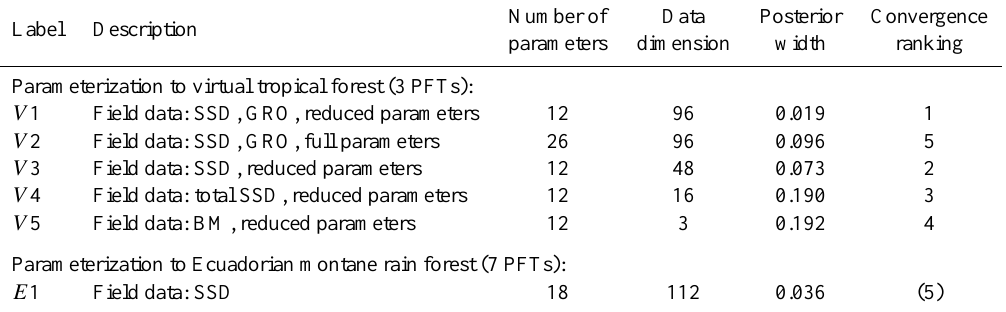
Table 2. Overview of parameter estimations with different models, parameters and summary statistics. Abbreviations for the data: SSD = stem size distribution (16 10cm classes); GRO = mean stem diameter growth for each of the 16 10cm stem diameter classes; BM = biomass. If not stated otherwise, the data type was available for each PFT separately. If we use the mean over all PFTs, we label this “total”. “Full parameters” means that all parameters listed in Tables 1 and 2 of the Supplement are estimated inversely. “Reduced parameters” means that only recruitment, mortality, maximum growth and maximum growth diameter are estimated. “Number of parameters” and “data dimension” give the number of parameters and data points, respectively. “Posterior width” measures the posterior width of the marginal distributions by the ratio between marginal posterior standard deviation and uniform prior width averaged over all parameters. “Convergence ranking” provides a ranking of the speed of convergence of the MCMCs based on the convergence diagnostics discussed in the Supplement. Lower numbers indicate fastest convergence. As E1 uses different data and a different number of PFTs, the convergence ranking is not fully comparable and was set in